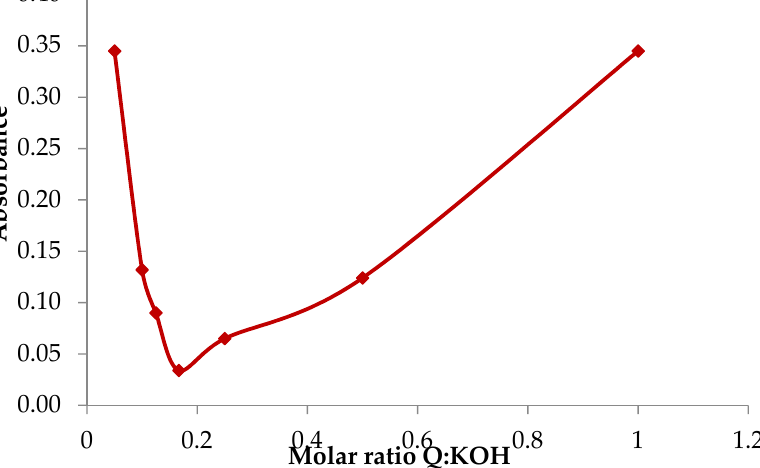
Figure 1. Determination of optimal molar ratios between the reagents by Job’s method.